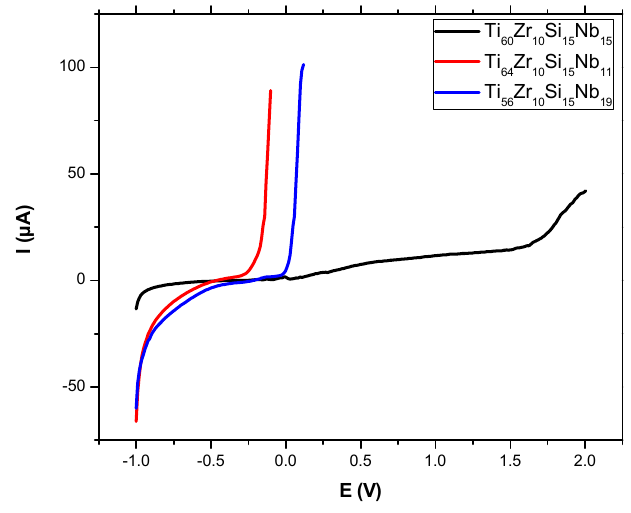
Figure 13. Polarization curves in NaCl 0.9% for bulk alloy samples.